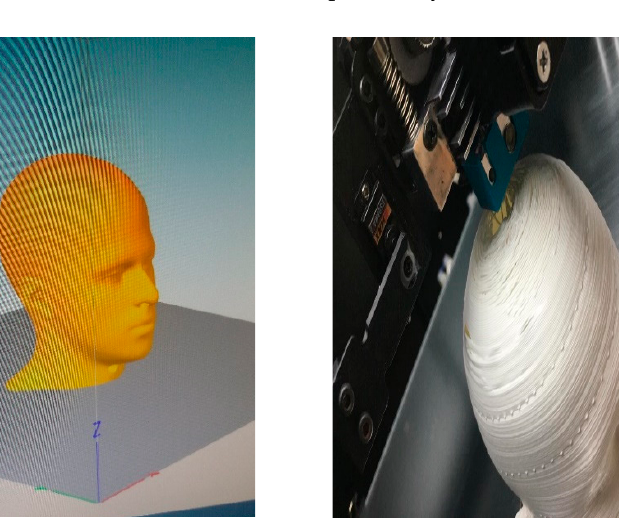
( d ) Figure 2. The resistance and sensor application stages on the head model. ( a ) Thermal head resis- tor and sensor layout. ( b ) The state of the 3D print head model before it is processed. ( c ) Laying of the temporary resistance wire on the head model. ( d ) Resistors embedded in the thermal head model and painted. The thermal head system is, basically, a heating and multi-sensor measurement sys- tem. The structure of this system is depicted in Figure 3. A control circuit was placed on the head model for the operation of the system. There were six temperature and humidity